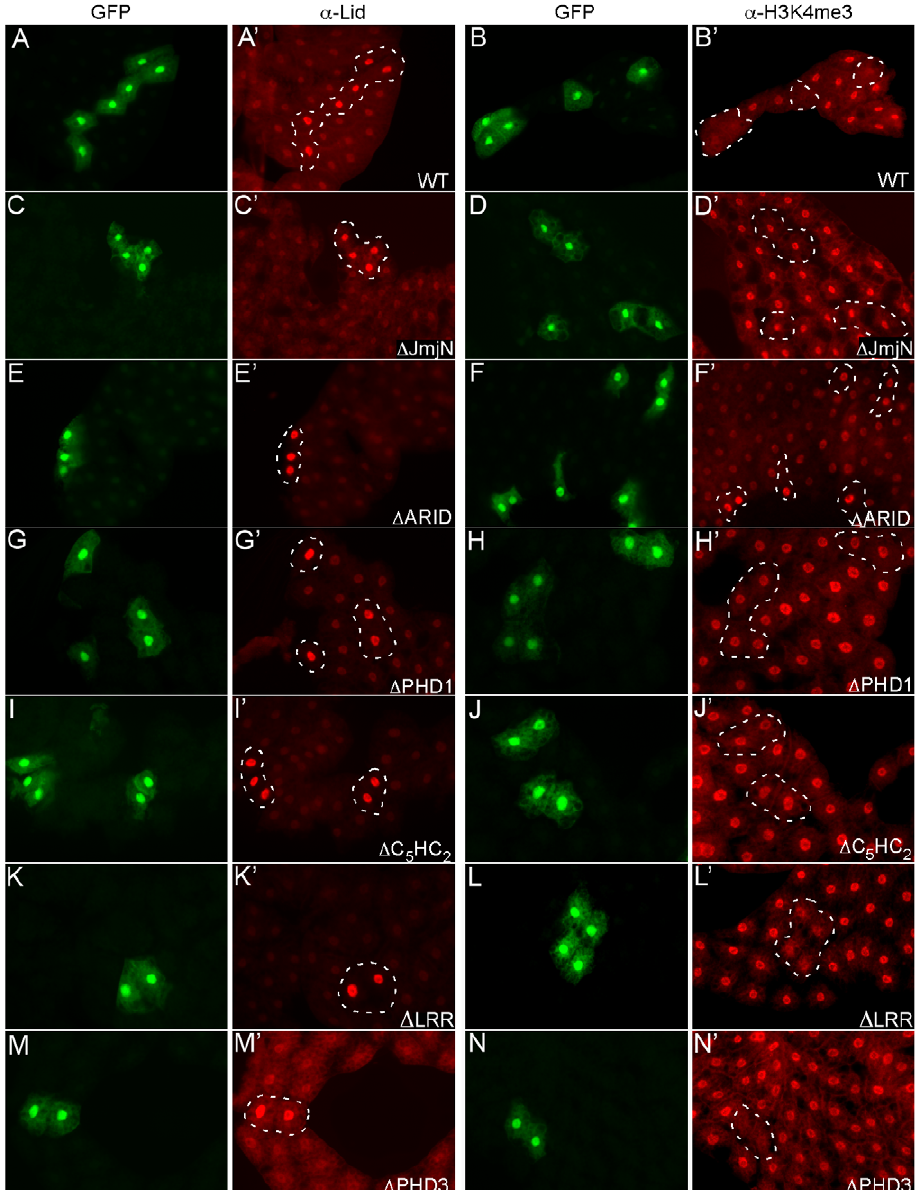
Figure 1. Deletion of Lid’s JmjN, ARID, and PHD1 domains abrogate its demethylase activity. Clones of cells expressing Lid or Lid mutant transgenes in fat body were generated by crossing hs-FLP; UAS-Lid females to act . CD2 . Gal4, UAS-GFP males. No heat shock was carried out since leaky FLP expression during embryogenesis leads to a small number of fat body clones. Levels of Lid (A’, C’, E’, G’, I’, K’, M’) and trimethylated H3K4 (B’, D’, F’, H’, J’, L’, N’) were examined. Cells expressing each transgene (as labeled on figure) are marked by co-expression of GFP and are outlined in the other panels.